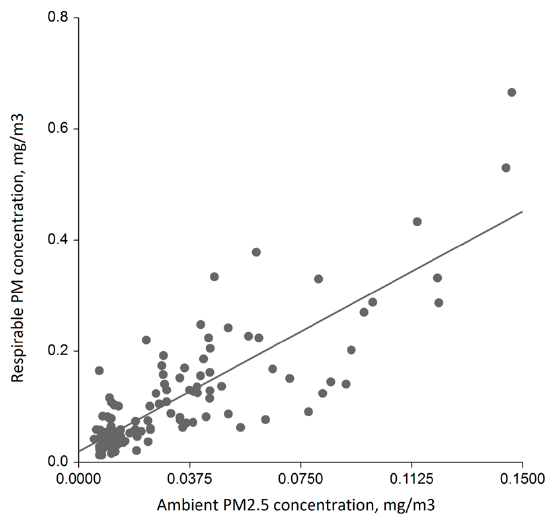
Figure 2. Daily median respirable PM concentrations (in mg/m 3 ) in twelve sampled salons (Kruskall–Wallis p < 0.001). Boxes are interquartile ranges (IQR), whereas whiskers represent one more IQR.